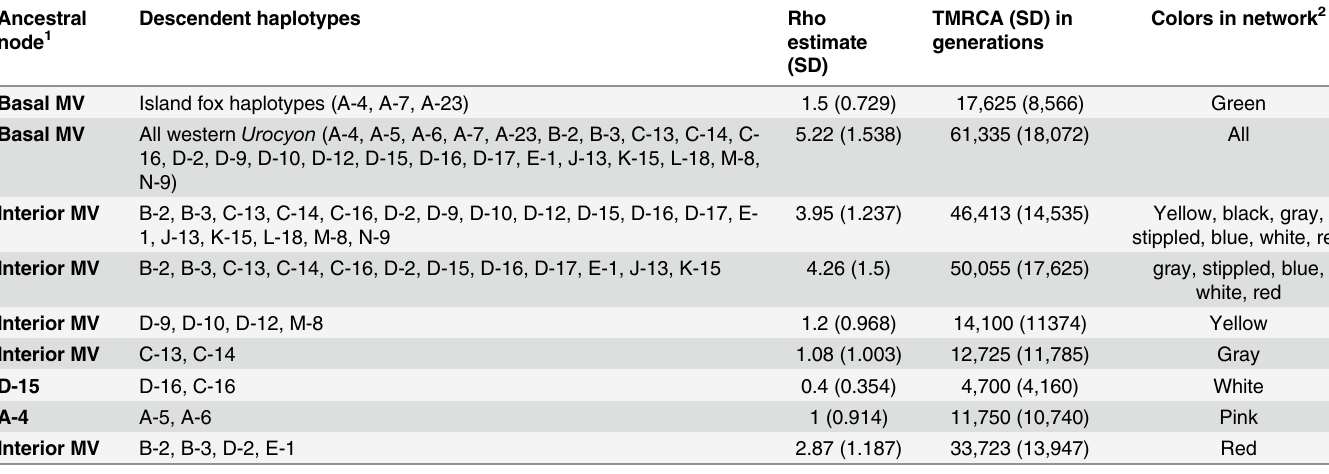
Table 2. Average (and standard deviation, SD) numbers of mutations separating descendent haplotypes from ancestral nodes (rho) and corre- sponding estimates of time to most recent common ancestor (TMRCA) assuming an average substitution rate of 10.8% per million generations in the 785 bp concatenated cytochrome b and D loop fragment.